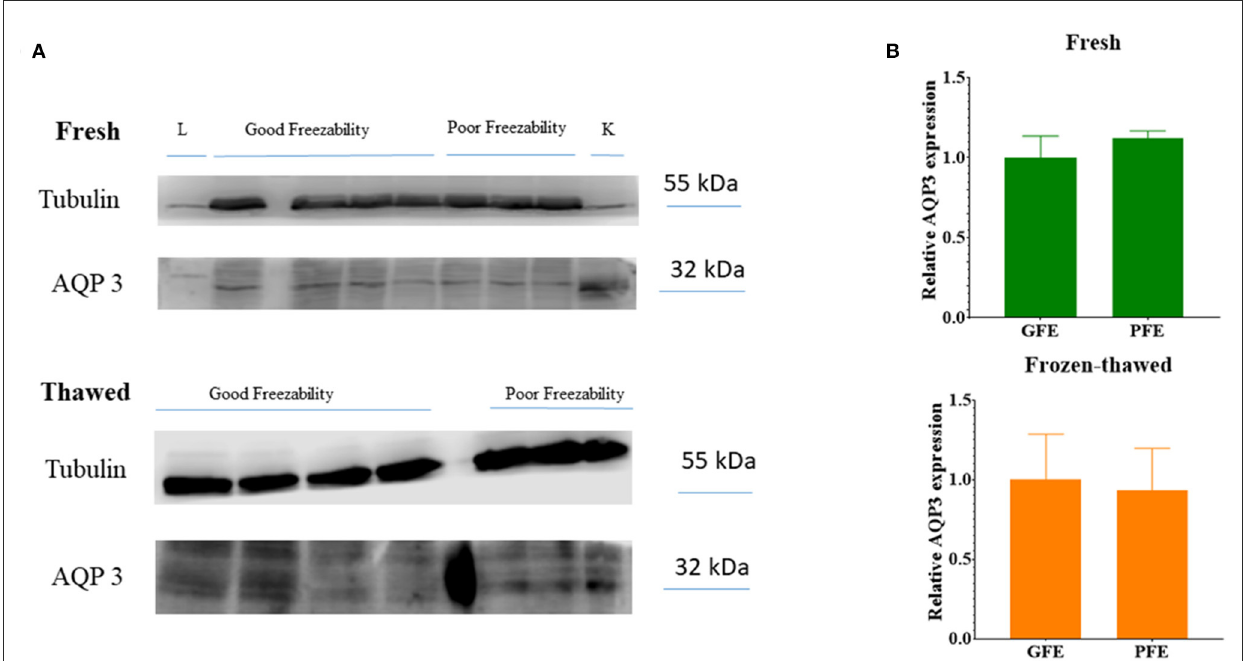
FIGURE6 (A) Immunoblots for AQP3 in fresh and frozen-thawed ram spermatozoa of ejaculates classified as of good (GFE) or poor freezability (PFE). L, Liver; K, kidney. (B) Relative abundances of AQP3 bands (as mean ± SEM) in GFE and PFE from fresh and frozen-thawed samples. No significant differences were found between GFE and PFE after quantification of 32 kDa bands and normalization using tubulin protein as an internal